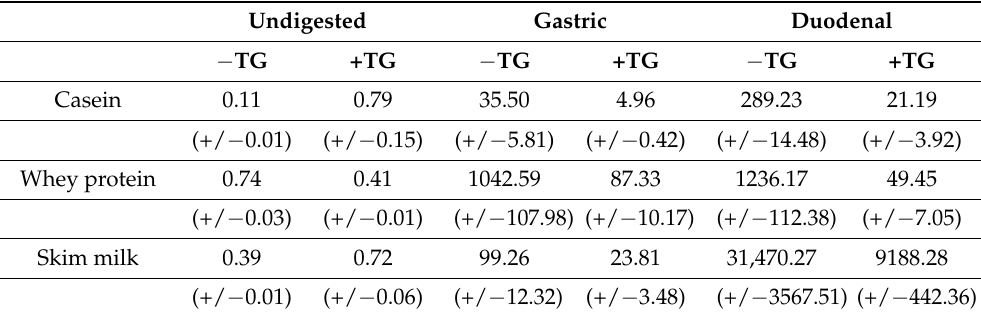
Table 2. IgE binding to untreated and TG cross-linked slim milk (SM), casein (CN), and whey pro- teins (WP), before and after gastric and duodenal digestion, as estimated by inhibition ELISA with sera from milk allergic patients (EC50, µg/mL).